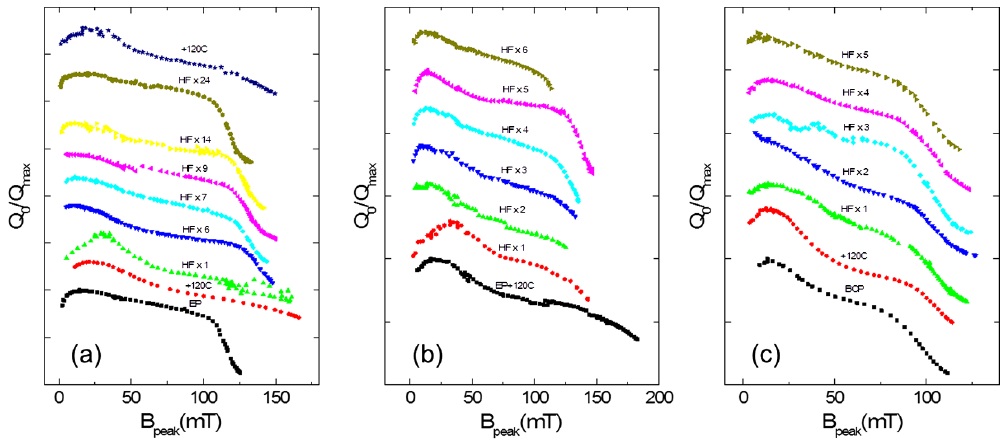
FIG. 5. Evolution of Q 0 ð B peak Þ curve shapes with multiple HF rinse cycles for: (a) electropolished cavity TE1ACC005; (b) electropolished cavity TE1ACC002 with tumbling to a mirror smooth finish as one of the processing steps; (c) buffered chemical polished cavity TE1AES003.